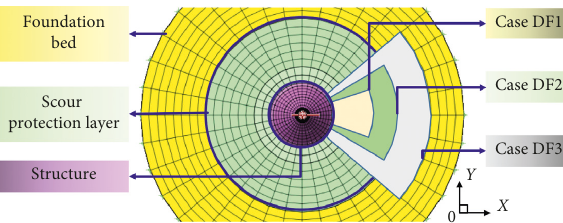
Figure 11: Simulation of scouring in the foundation bed.